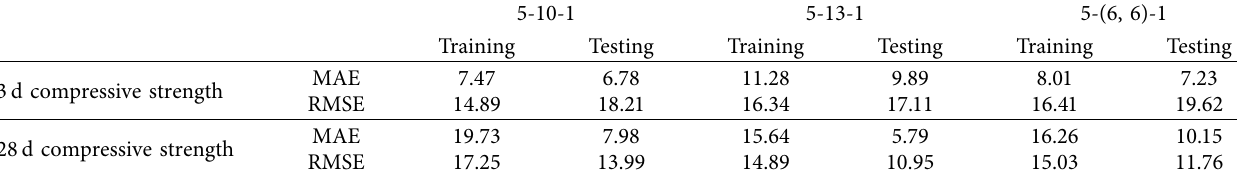
Table 3: Performance comparison between different network structures